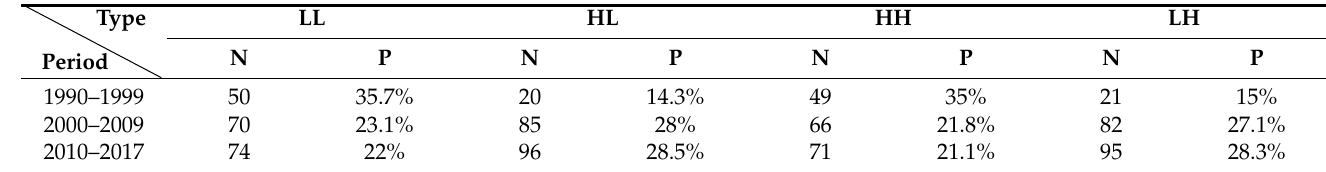
Table 5. Prevalence of the four types of node